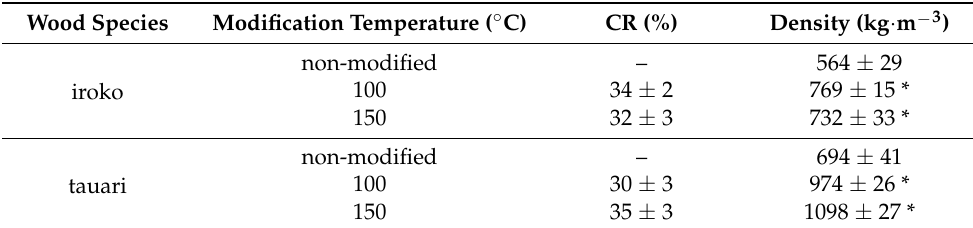
Table 2. The compression ratio (CR) and density of thermo-mechanically modified iroko and tauari wood; ± (SD). Wood